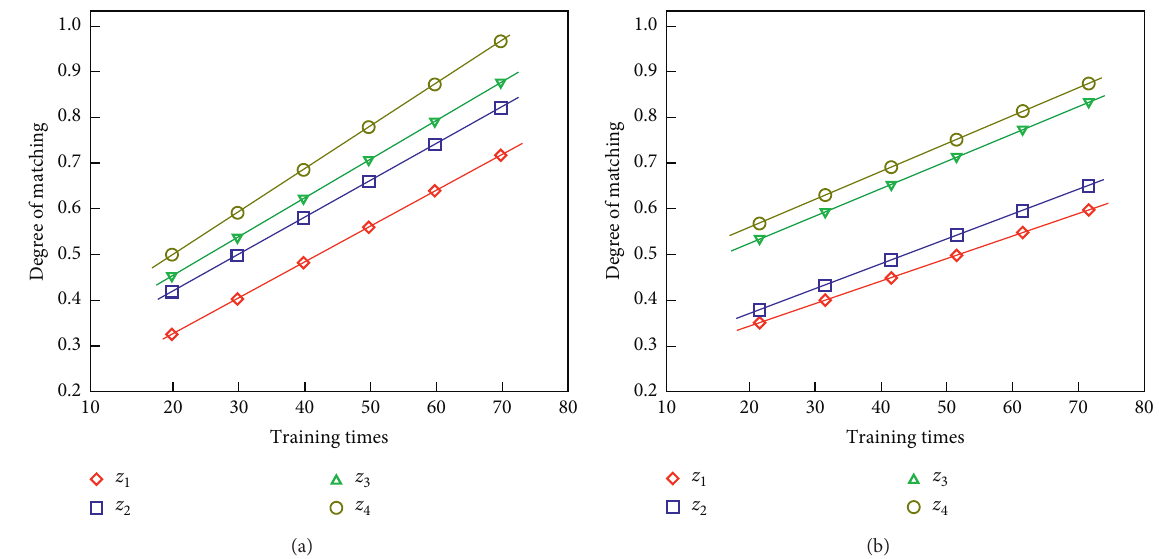
Figure 6: (a) Degree of matching of four typical children’s psychological distresses using deep spatiotemporal feature extraction algorithm and (b) dynamic scene understanding algorithm; z 1 , solitary scene matching; z 2 , social scene matching; z 3 , entertainment scene matching; z 4 , learning scene